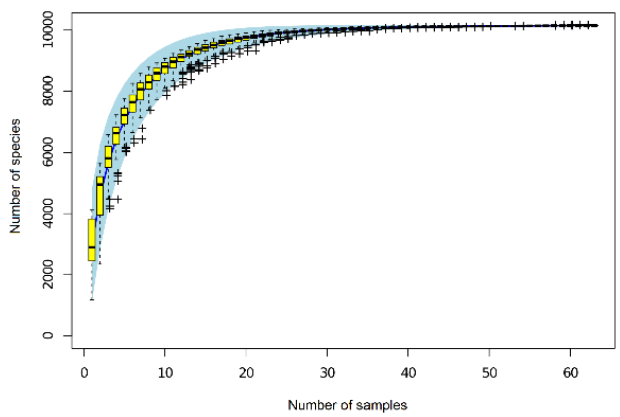
Figure 2. Species accumulation curves (boxplots) in Haplic Cambisols treated with graphene.